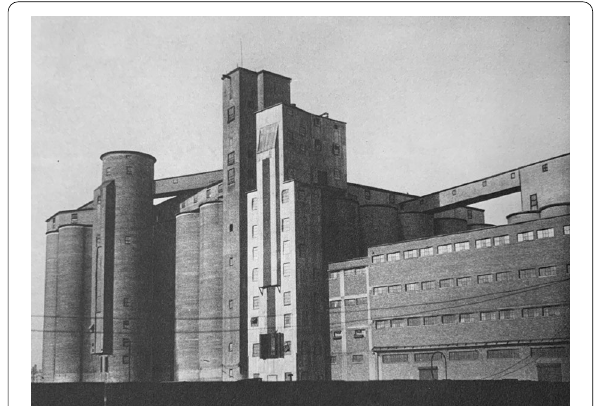
Fig. 3 Grain silos. Buffalo, New York. Erich Mendelsohn. 1926. From his book Amerika. Bilderbuch eines Architekten (Berlin: Rudolf Mosse/ Buchverlag, 1926)